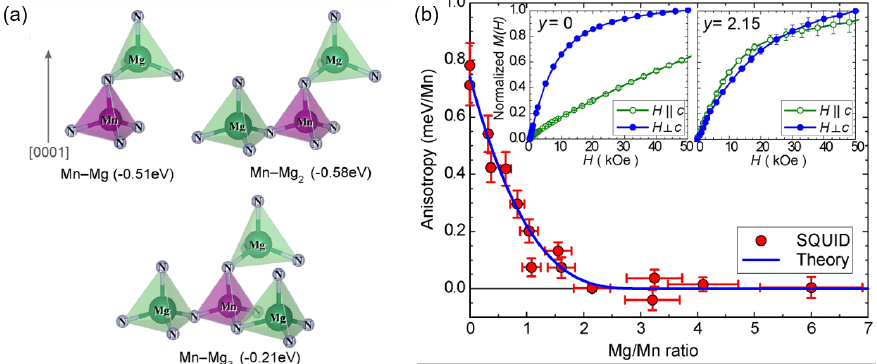
Figure 4. Tunable spin Mn-Mg k complexes in Ga 1 − x Mn x N grown by MOVPE that serve to modify the magnetic anisotropy of the layers: ( a ) Schematic representation of the complexes, and ( b ) magnetic anisotropy as a function of Mg/Mn ratio. Adapted from Reference